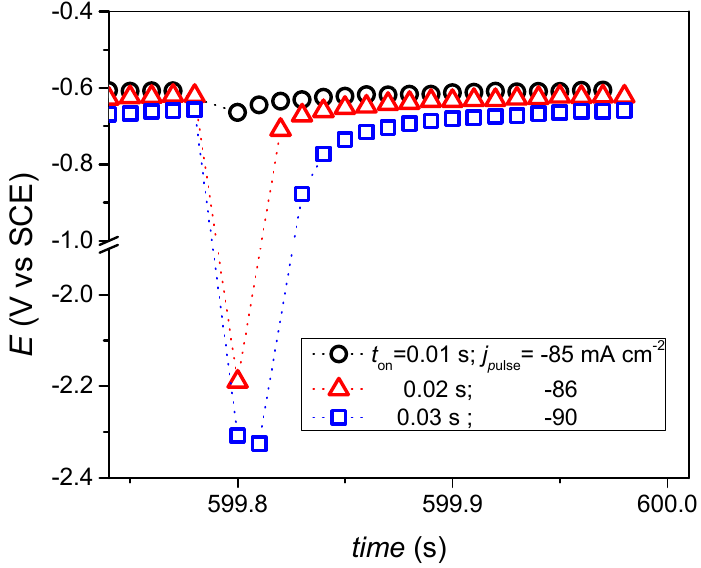
Figure 2. Typical cathode potential change (decay) during one period of pulse plating (PP). The elemental composition of the samples obtained from the SEM-EDX analysis are given in Table 2, which reflects similar dependences on deposition parameters, as reported earlier